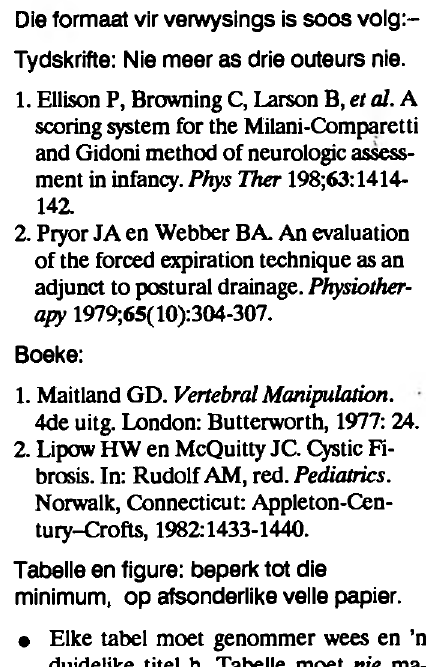
minimum, op afsonderlike velle papier. duidelike titel h. Tabelle moet nie ma­ teriaal wat in die teks verskyn weergee nie. Alle tabelle en figure moet in die teks in agtervolgende orde genoem